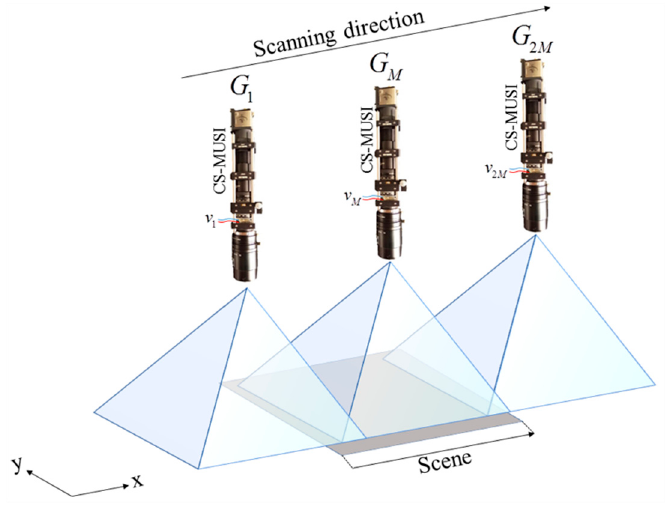
Figure 10. CS-MUSI camera along-track scanning. Each shot of the CS-MUSI camera, i G , captures a shifted scene with a different LC spectral transmission (which depends on the voltage i v